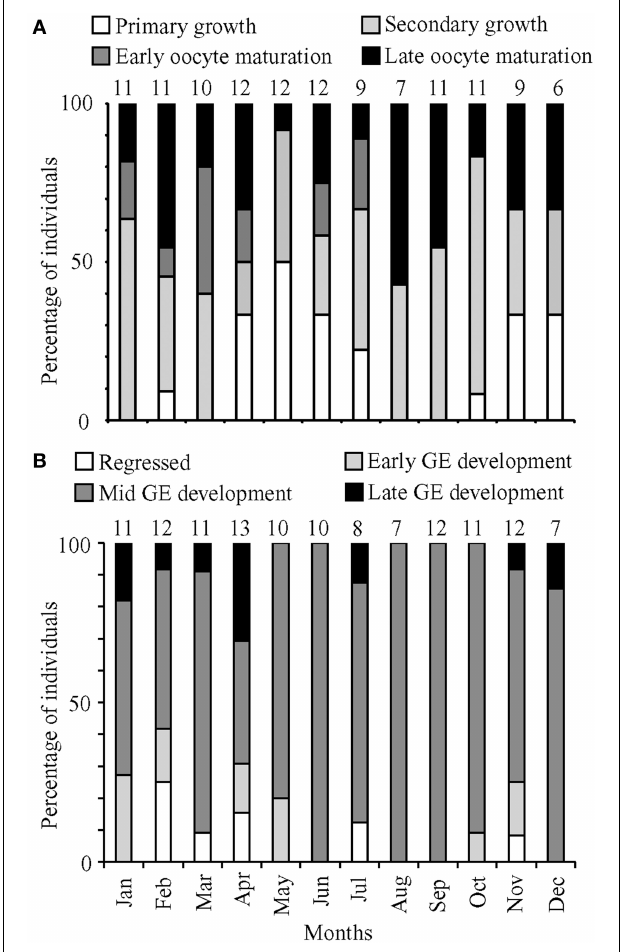
FIGURE 3 | Percentage of (A) female and (B) male fish in the most advanced development stage or maturation phase observed, respectively, for months from January to December 2011. Numbers above bars represent monthly sample